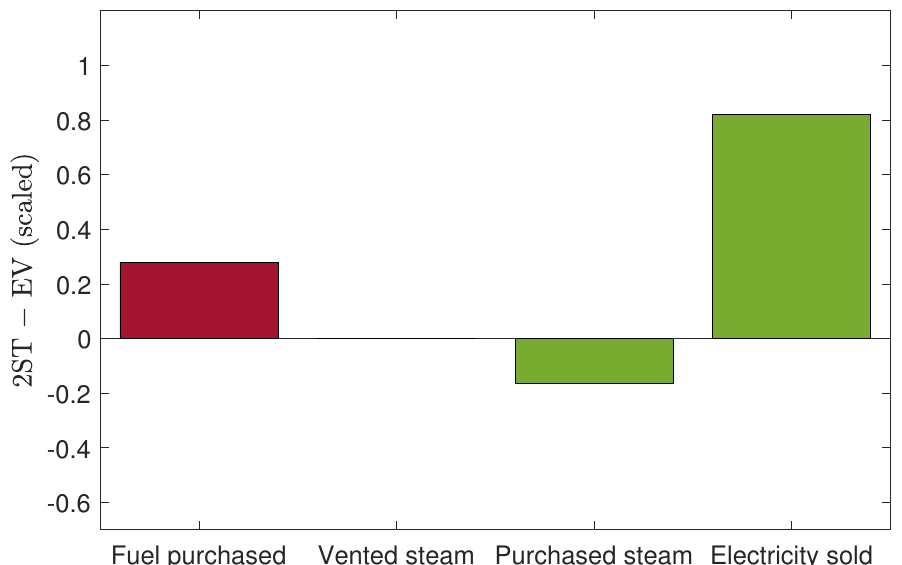
Figure 12. The comparison of the financial factors of the solutions 2ST and